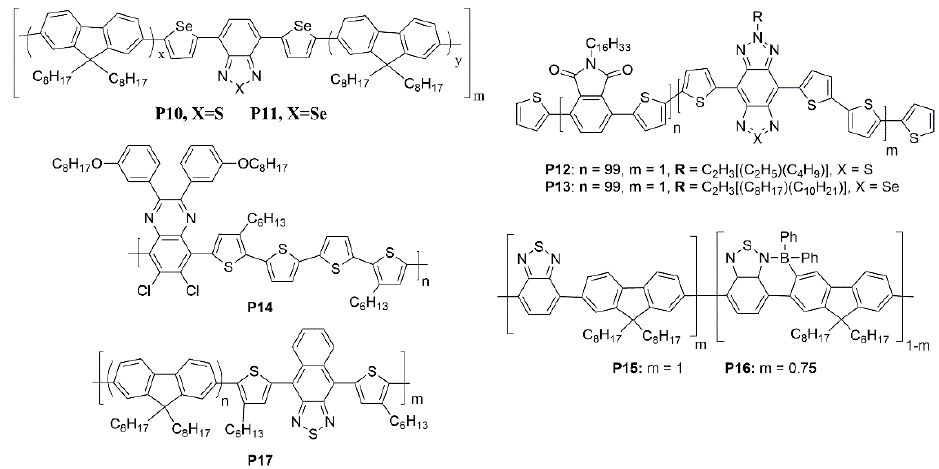
Figure 6. Chemical structures of P10 to P17 .